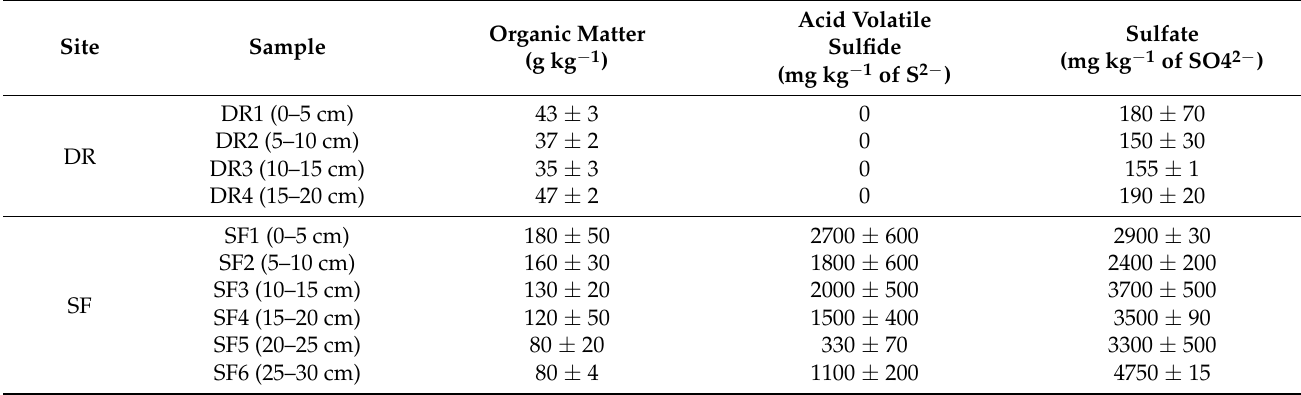
Table 2. Organic matter, acid volatile sulfide, and sulfate content in the vertical profile of the sediments collected at the DR and SF sites, Reconquista